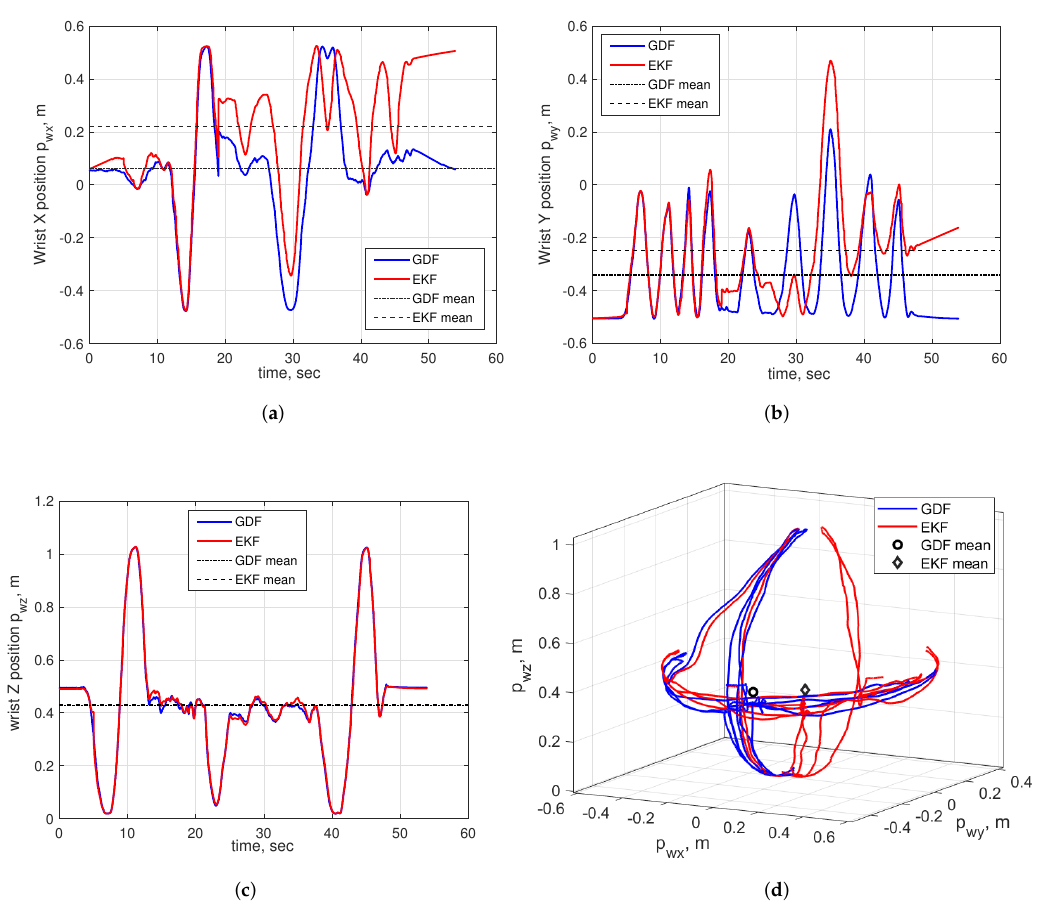
Figure 11. Estimated wrist position trajectories of a human operator performing several left-to-right and up-down arm movements: time evolutions of x ( a ), y ( b ) and z ( c ) wrist coordinates; ( d ) - 3D wrist movement